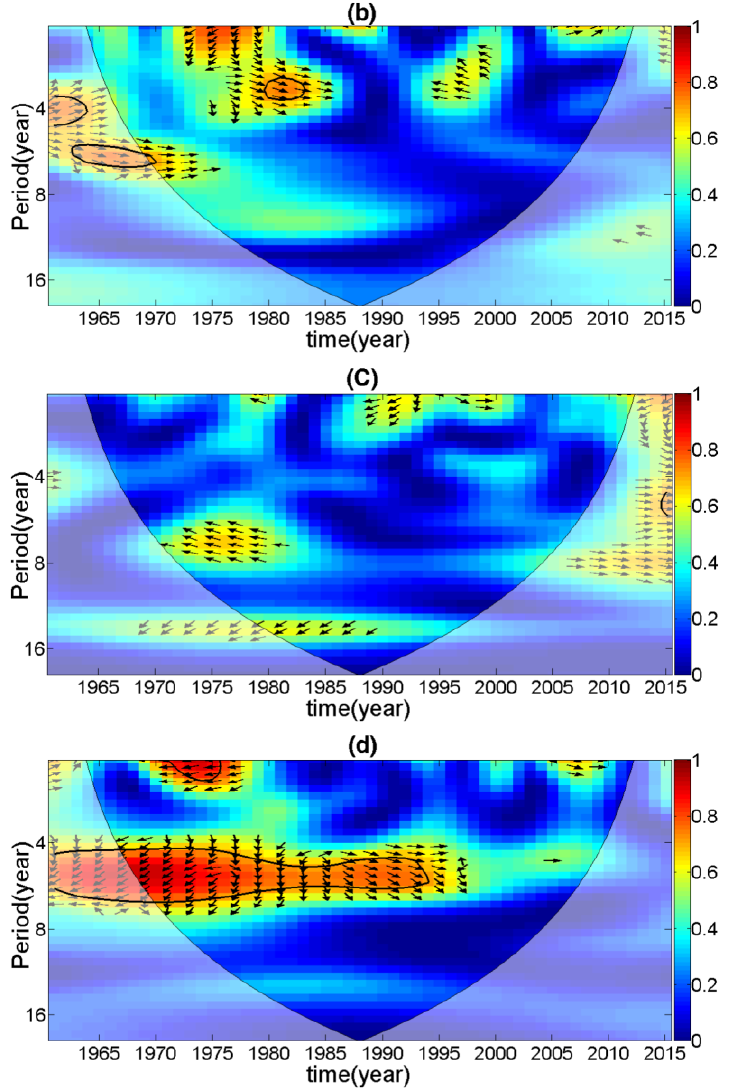
Figure 10. Cross wavelet between: ( a ) EHT and GMT; and ( b ) ELT and global mean temperature (GMT). Cross wavelet between: ( c ) EHT and TGBXB; and ( d ) ELT and TGBXB.